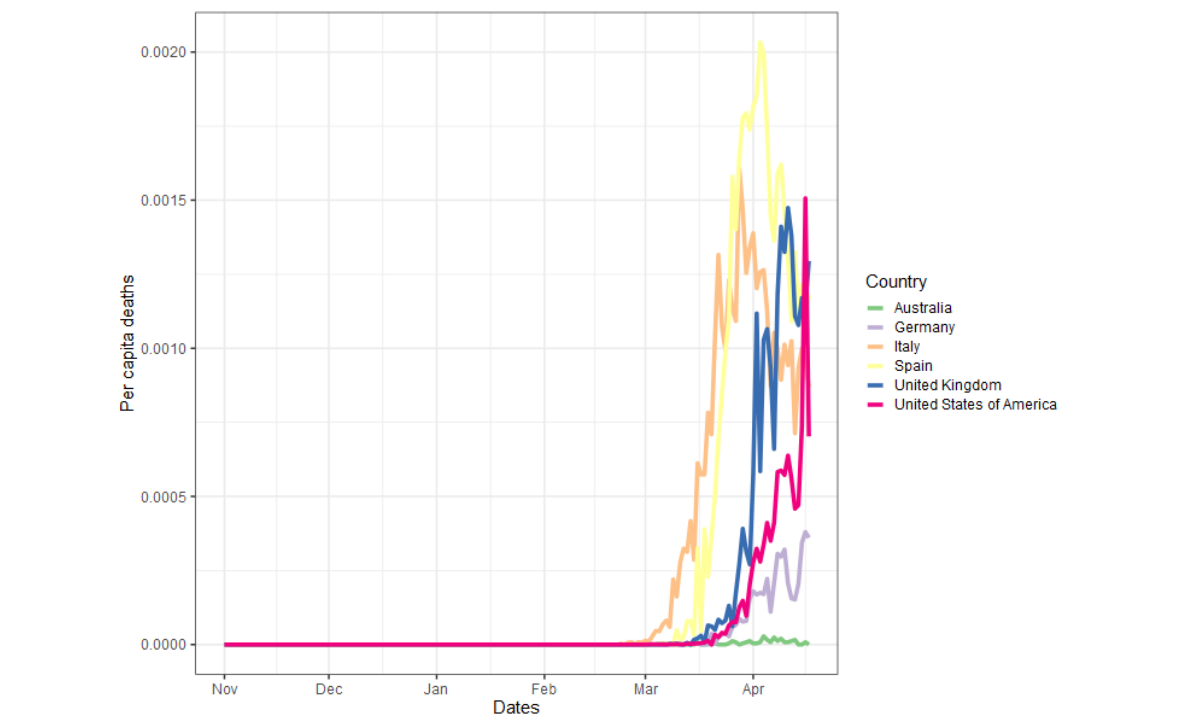
Figure 3. Per capita COVID-19–related deaths during the study period.